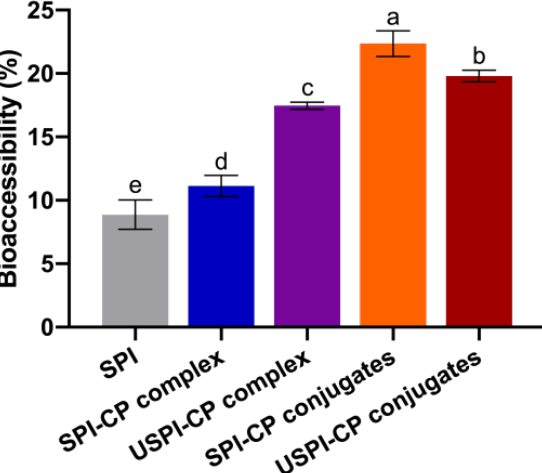
Figure 4. Bioaccessibility of β -carotene nanoemulsions stabilized by different emulsifiers. Different letters (a–e) indicate significant differences as estimated by Duncan’s multiple range test ( p < 0.05). Samples: SPI, soy protein isolate; SPI–CP complex, electrostatic complex formed between soy protein isolate and citrus pectin; USPI–CP complex, electrostatic complex formed between soy protein isolate and citrus pectin with ultrasound treatment; SPI–CP conjugate, Maillard-type conjugate formed between soy protein isolate and citrus pectin; USPI–CP conjugate, Maillard-type conjugate formed between soy protein isolate and citrus pectin with ultrasound treatment.